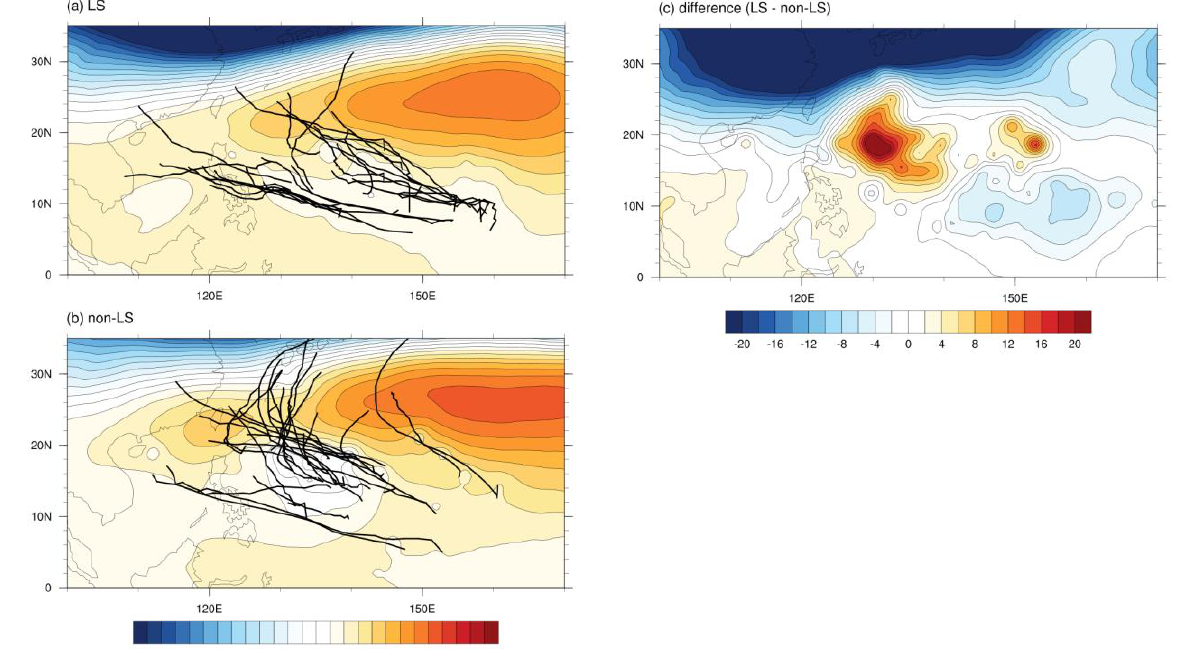
Figure 6. Composite geopotential height (gpm) at 500 hPa for ( a ) the LS TCs, ( b ) the non-LS TCs, and ( c ) their difference. The solid lines are the TC tracks of each group simulated from 2DM experiments.